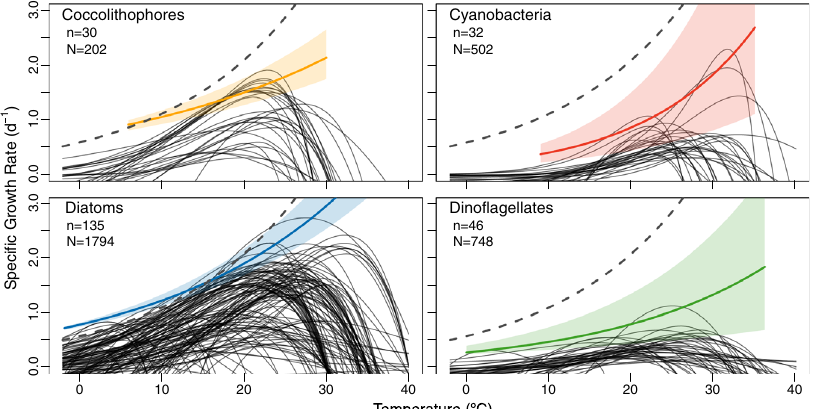
Fig. 1 Thermal reaction norms for each phytoplankton functional type. Modeled exponential curves (colored lines) were fi t to measured growth rates ( N ) using a 99th quantile regression and compared to the widely-used Eppley curve 28 , which assessed phytoplankton collectively (gray dashed line, same in each panel). Extent of modeled curves (colored lines) denote limits of data. The 95% con fi dence intervals (shading) were determined using Markov chain marginal bootstrapping 75 and are centered at the median. Thermal reaction norms ( n) for each isolate characterized are shown in black. The cyanobacteria group does not include diazotrophic species ( “ Methods ” ).